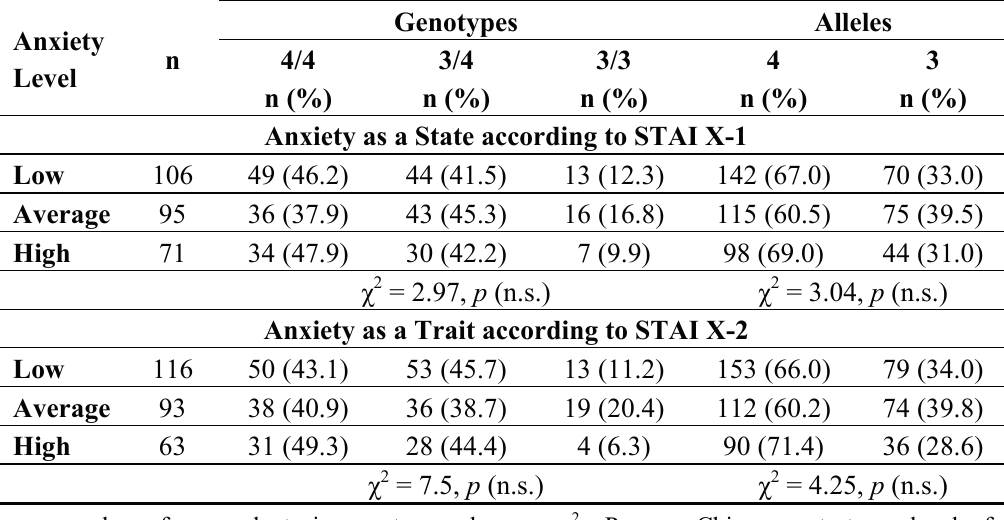
Table 3. Distribution of genotypes and alleles frequency of the 30-bp VNTR polymorphism in the MAO A promoter region, and the severity of anxiety as a state according to STAI X-1 and as a trait acc. to STAI